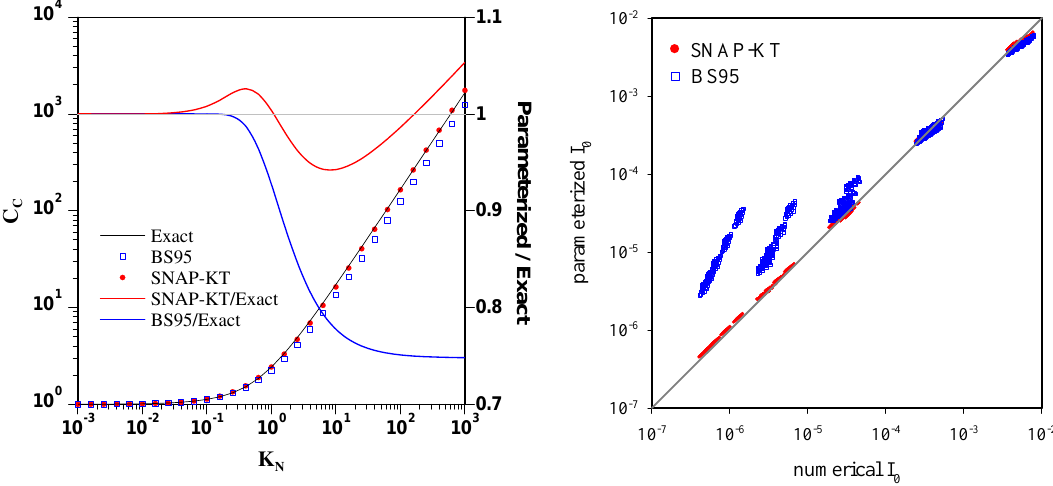
Fig. 5. (a) Cunningham slip-flow correction (left ordinate) as a function of the Knudsen number K N . The exact solution, BS95 and SNAP-KT results are given as the black solid line, blue squares, and red dots, respectively. Also shown on the right ordinate are the ratios of BS95 (blue curve) and SNAP-KT (red curve) results to the exact solution. (b) Comparison of parameterized group sedimentation velocity (ordinate) against the exact numerical solution (abscissa).